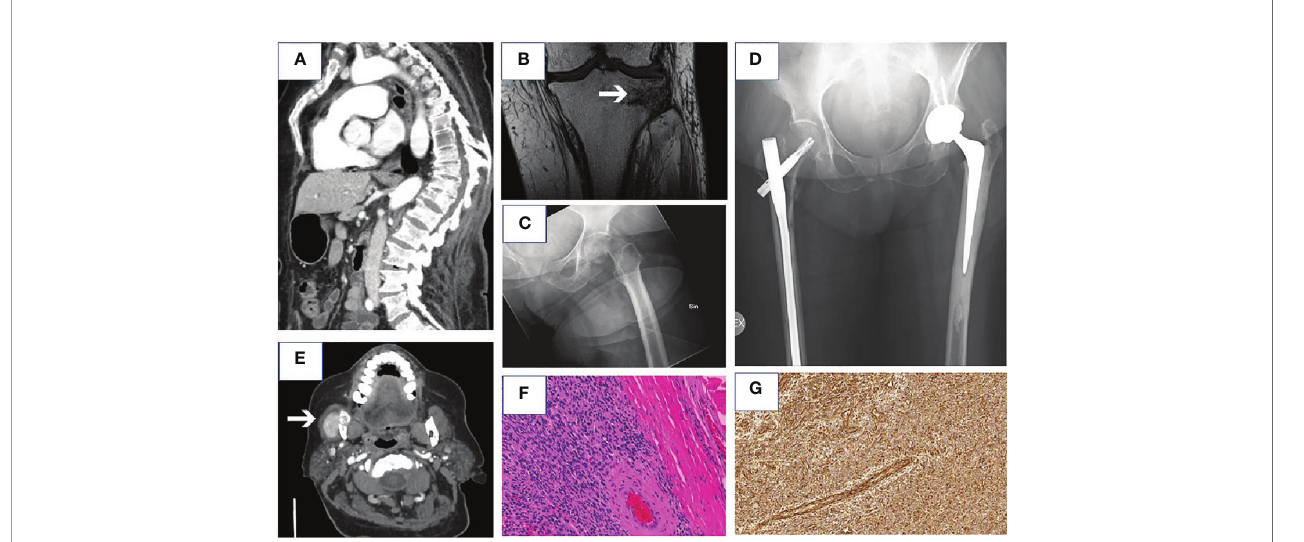
FIGURE 1 | Radiological images of the fragility fractures diagnosed before the diagnosis of TIO. Compression fractures and kyphoscoliosis of the spine in CT (A) , MRI scan showing fragility fracture of the lateral condyle of the right tibia (B) , X-ray of the fragility fracture of left femoral neck (C) and X-ray of pelvis showing arthroplasty of the left hip and osteosynthesis performed after fragility fractures in right femoral shaft and lateral condyle after surgery (D) . CT scan of the tumor in the mandible (E) , hematoxylin and eosin staining (F) (18.4 x) and vimentin staining (positive) (15.9 x) (G) of the tumor.